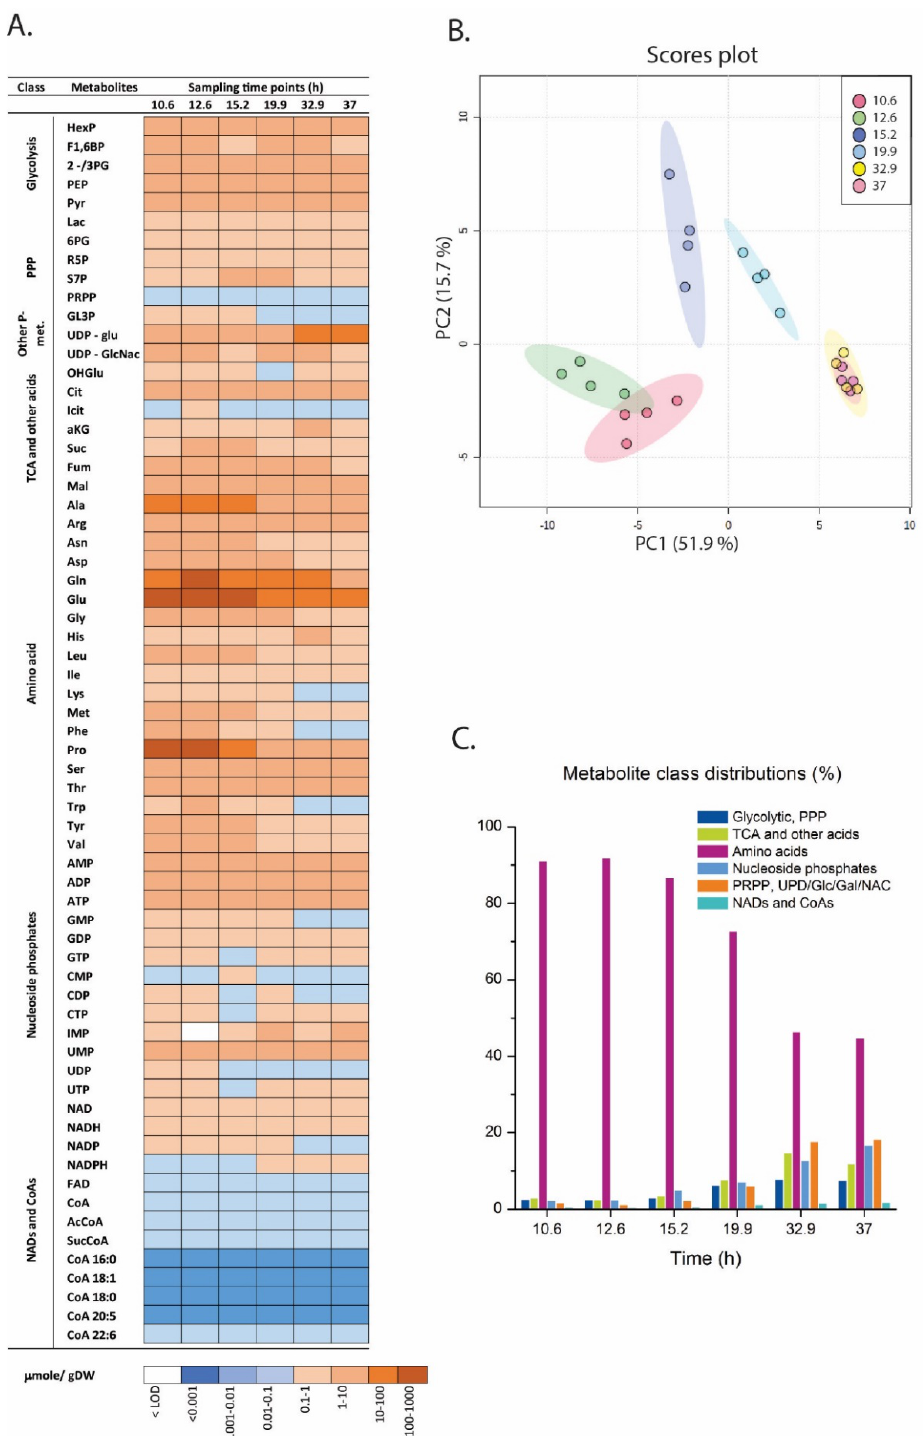
Figure 4. Intracellular metabolite profiling using the six MS based methods for six sampling points (10.6 and 12.6 h—growth phase; 15.2 and 19.9 h—transition phase; 32.9 and 37.0—lipid accumulation (LA) phase). ( A ) Absolute concentrations in μmol/g DW of all quantified metabolites. Average of four technical replicas from one representative biological